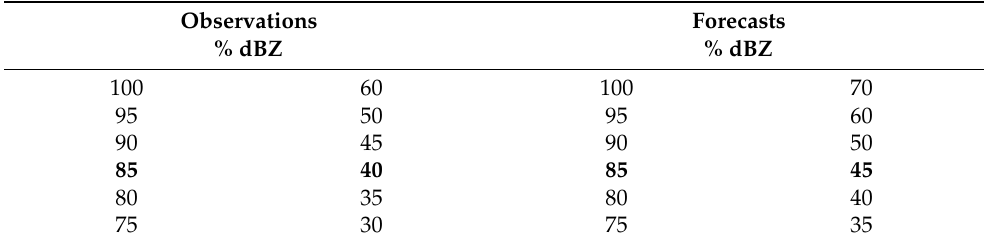
Table 1. Demonstration of bias correction procedure. Observed value of 40 dBZ is highlighted in bold to indicate the value selected for object definition.